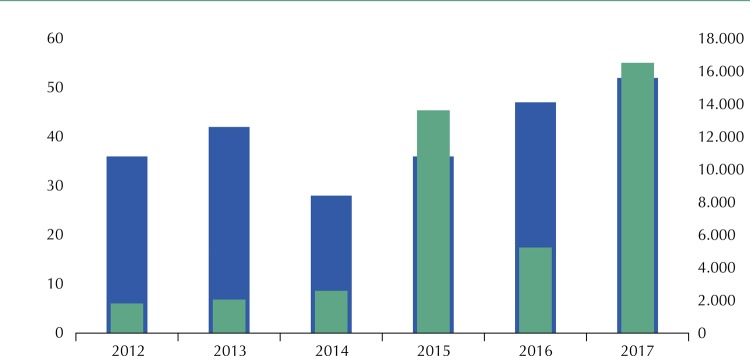
Número de consultas públicas e contribuições recebidas, por ano, até dezembro de 2017. Fonte: Conitec, 2018.